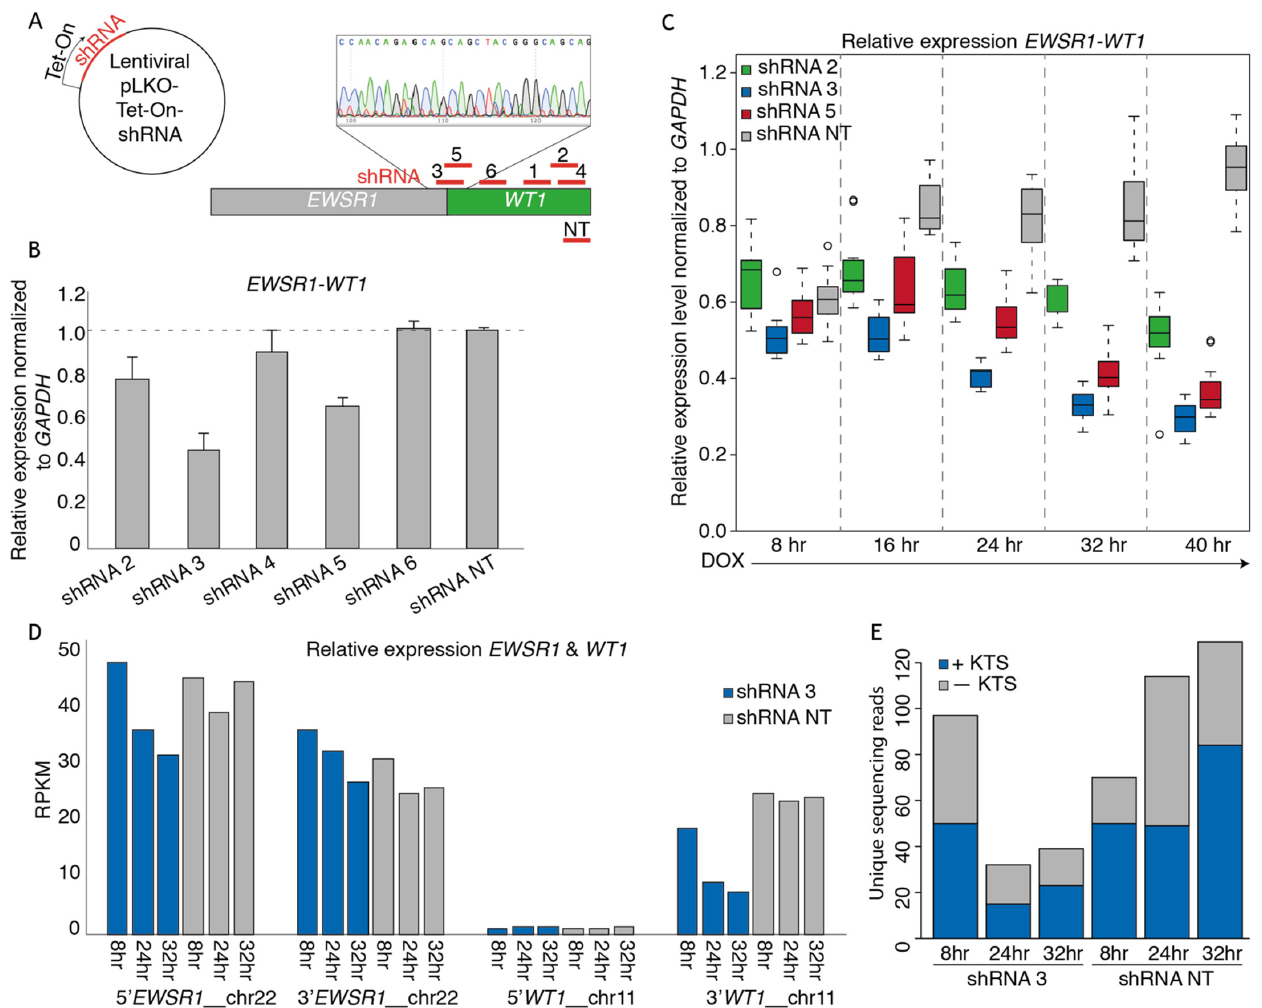
Figure 2. shRNA-mediated EWSR1-WT1 knock-down in the DSRCT in vitro model. ( A ) Animation depicting the design of shRNAs targeting the breakpoint of EWSR1-WT1 , 3 ′ WT1 , and a non-targeting (NT) shRNA. shRNAs were cloned into a lentiviral Tet-On backbone. ( B ) Bar plot depicting relative EWSR1-WT1 expression levels 24 h post-DOX-induction of shRNAs normalized to GAPDH , as determined by qPCR. ( C ) Box plot depicting relative EWSR1-WT1 expression levels at 8, 16, 24, 32, and 40 h post-DOX-induction of shRNA 2, 3, 5, and NT normalized to GAPDH , as determined by qPCR. ( D ) Bar plot depicting RPKM counts of 5 ′ EWSR1 , 3 ′ EWSR1 , 5 ′ WT1 , and 3 ′ WT1 at 8, 24, and 32 h post-DOX-induction of shRNA 3 and NT, as determined by mRNA paired-end sequencing. ( E ) Bar plot depicting number of +KTS (blue) and − KTS (gray) isoform reads, as determined by mRNA paired-end sequencing.